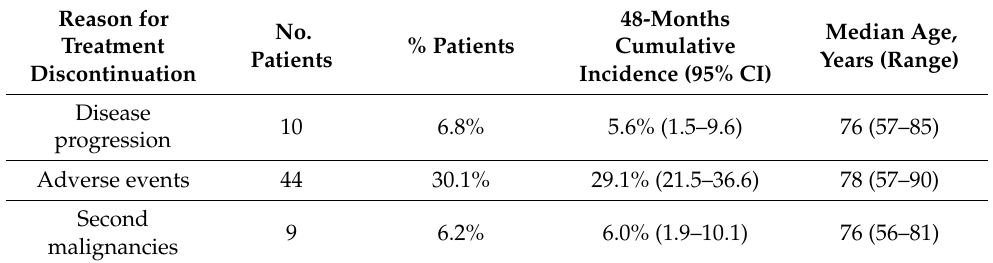
Table 3. Reasons for treatment discontinuation.